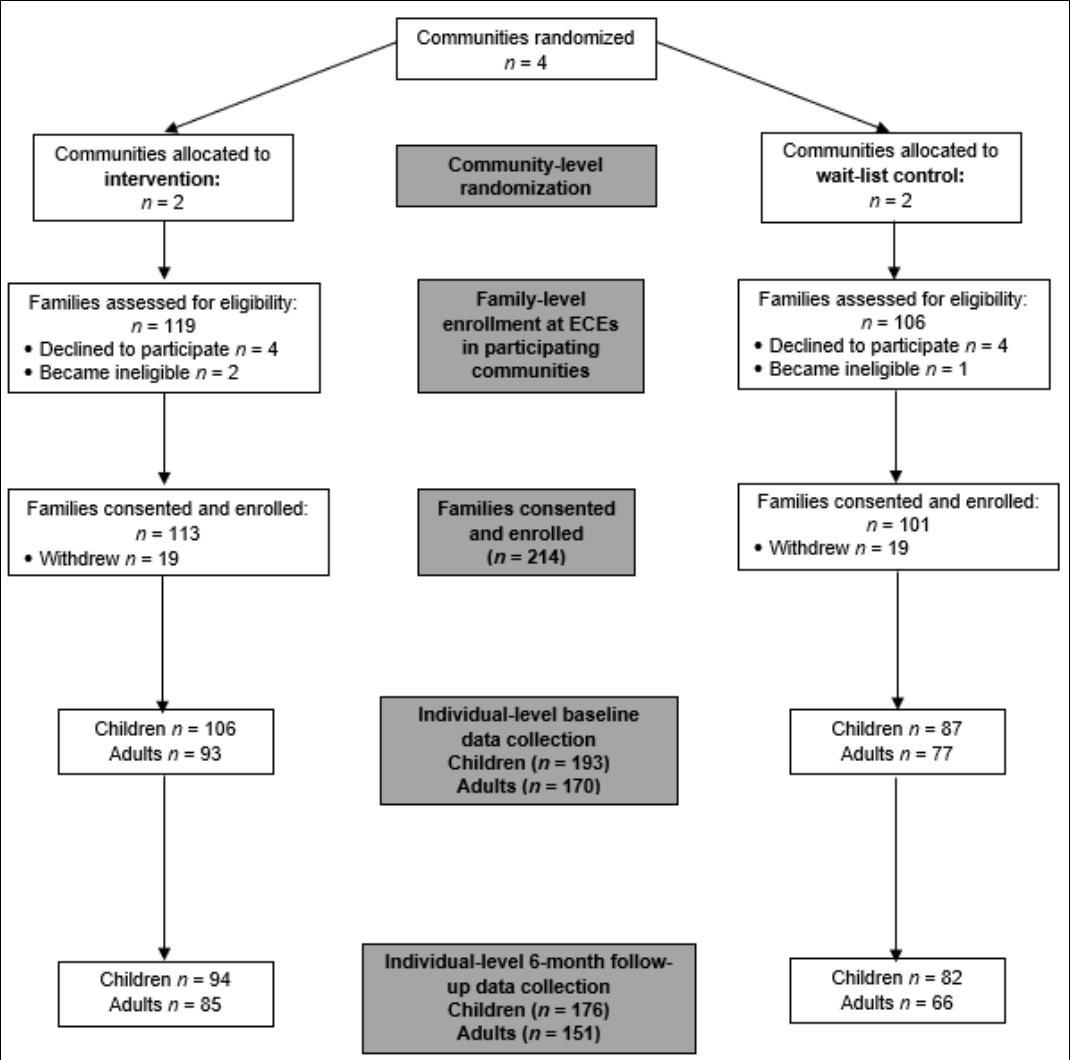
Figure 1. FRESH study community randomization, recruitment, and data collection in Osage Nation of Oklahoma.